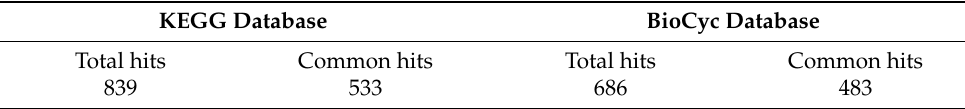
Table 1. Summary of metabolites hit by the two